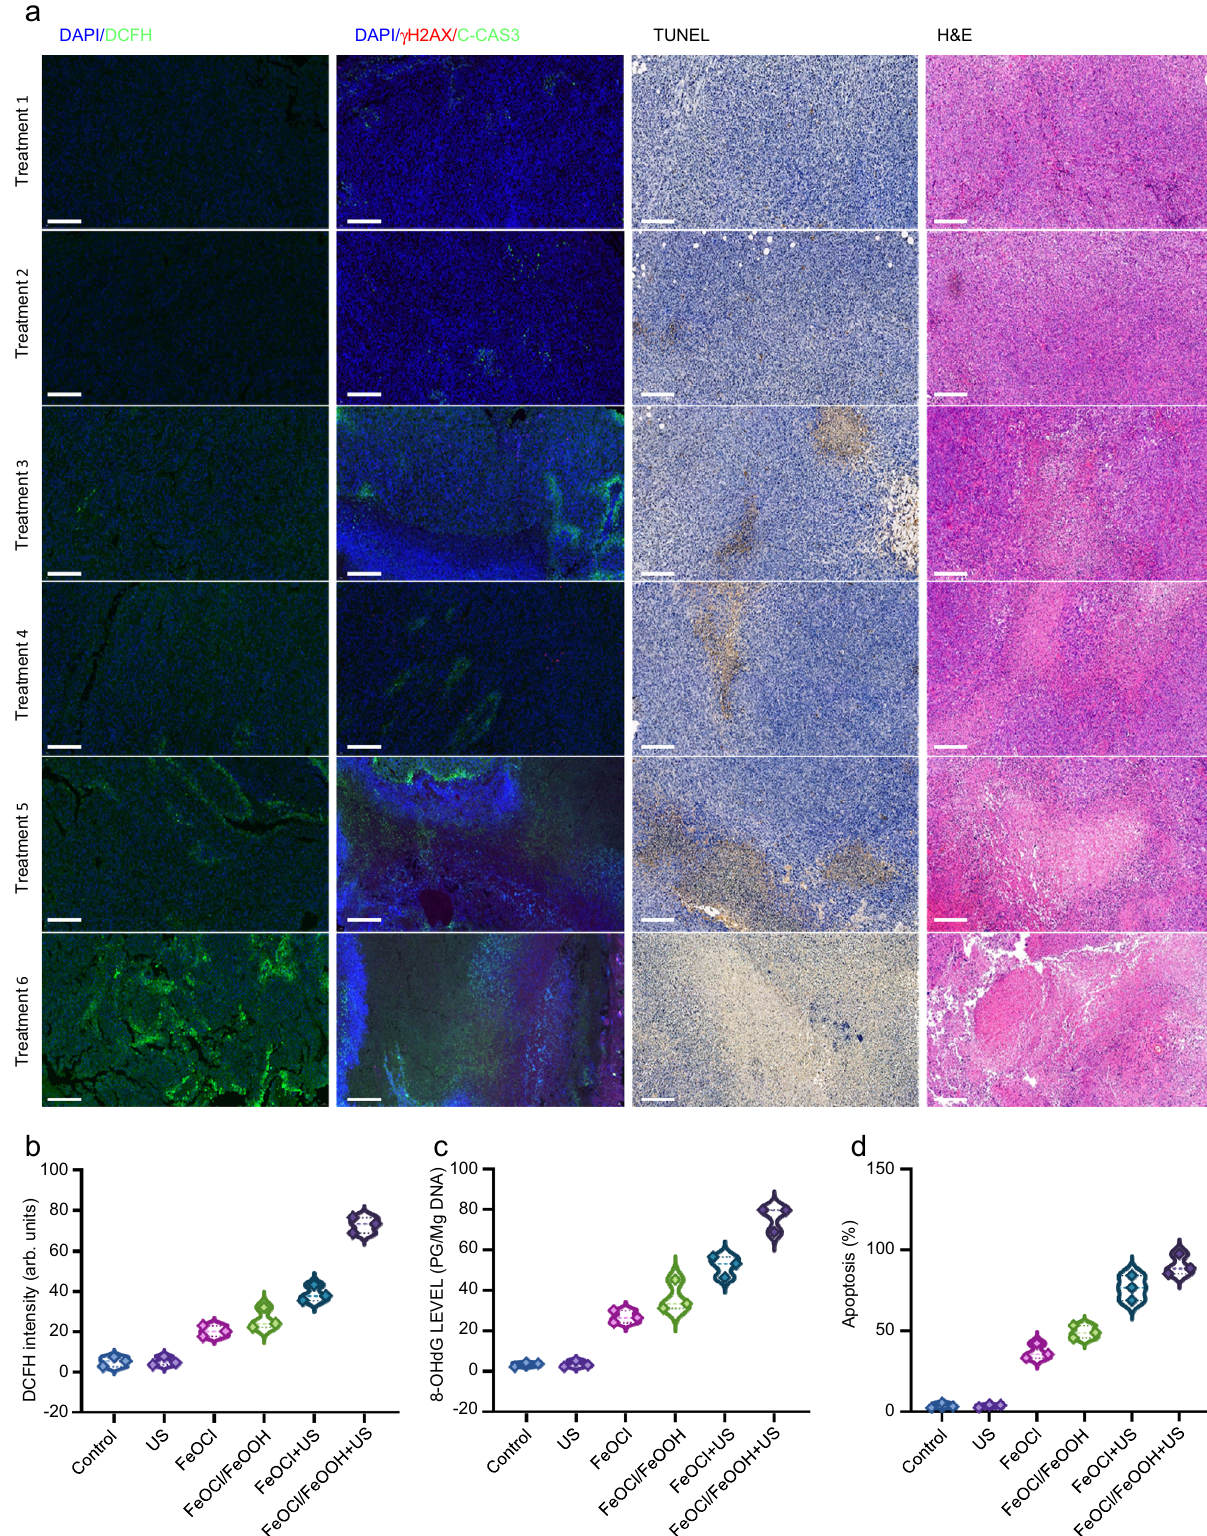
(HCT), hemoglobin (HGB), mean corpuscular hemoglobin (MCH), mean corpuscular hemoglobin concentration (MCHC), mean corpuscular volume (MCV), and platelet (PLT) counts were